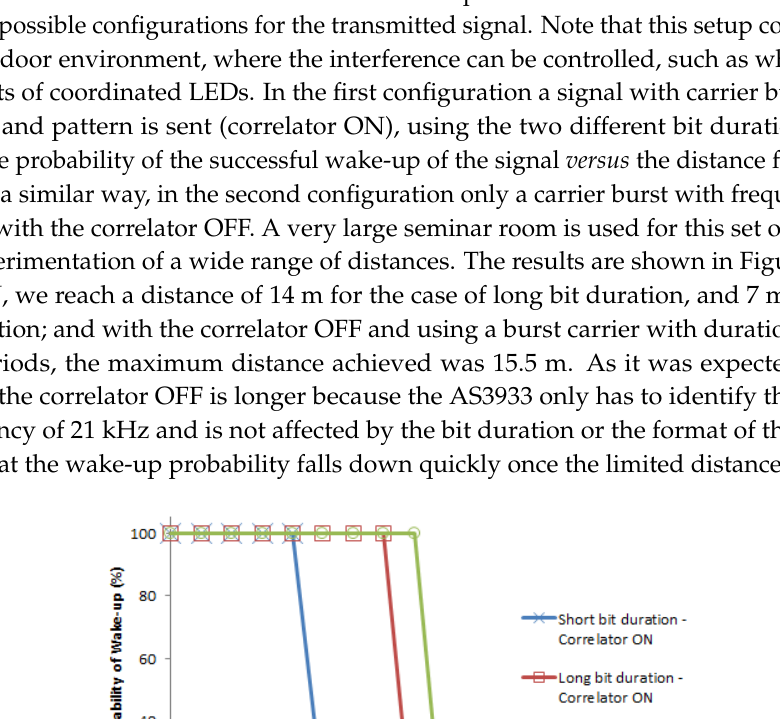
Figure 19. Probability of wake-up vs. distance for the correlator ON for the different receiver configuration under no interference scenario. The short distance reached with the receiver design option 2 is easily explained by the fact that with the indoor solar panel it is not possible to harvest enough power for the operation of the AS3933 from the amount of light emitted by this single LED at longer distances. Hence, using a capacitor and storing the energy (WuRx option 1) is necessary for the battery-less execution of the proposed VLC-based wake-up system. Based on these test results, it is clear that the distances achieved by the proposed system are enough for many indoor applications, such as asset control, tracking of devices, security systems, and others. 5. Conclusions and Future Work A wake-up receiver system that uses VLC for communication and an indoor solar panel for energy harvesting and reception of the VLC signal has been presented. The use of VLC for